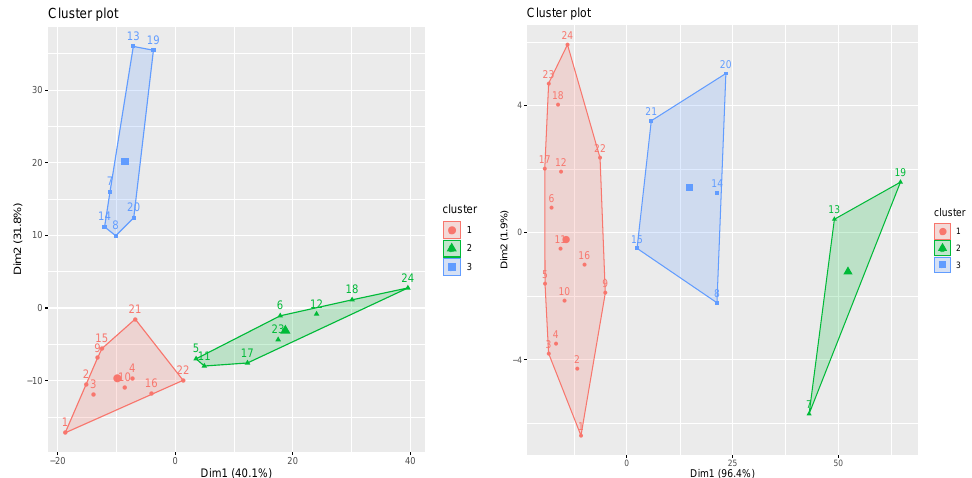
Figure 8. ( Top-left panel ) Cluster dendrogram for precipitation data. ( Top-right panel ) Cluster dendrogram for temperature data. ( Bottom-left panel ) cluster scatter plots for precipitation data. ( Bottom-right panel ) cluster scatter plots for temperature data.